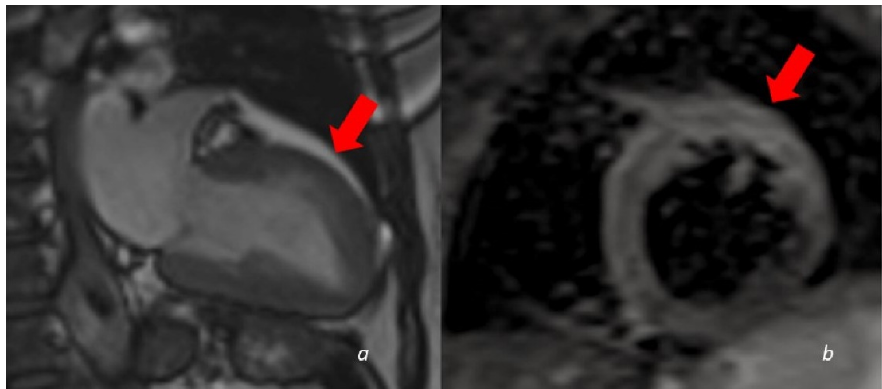
Figure 4. A 60 y/o woman presenting with acute chest pain and Troponin elevation with ECG alterations in the anterior leads. Echocardiogram showed dyskinesia of the anterior middle wall of the left ventricle. Subsequent cardiac MRI (24 h later) demonstrated dyskinetic movement in the anterior wall of the left ventricle ( a -cine images frame in the systolic phase showing anterior bulging), associated to edema in the anterior wall ( b ). No LGE was found in the myocardial wall.